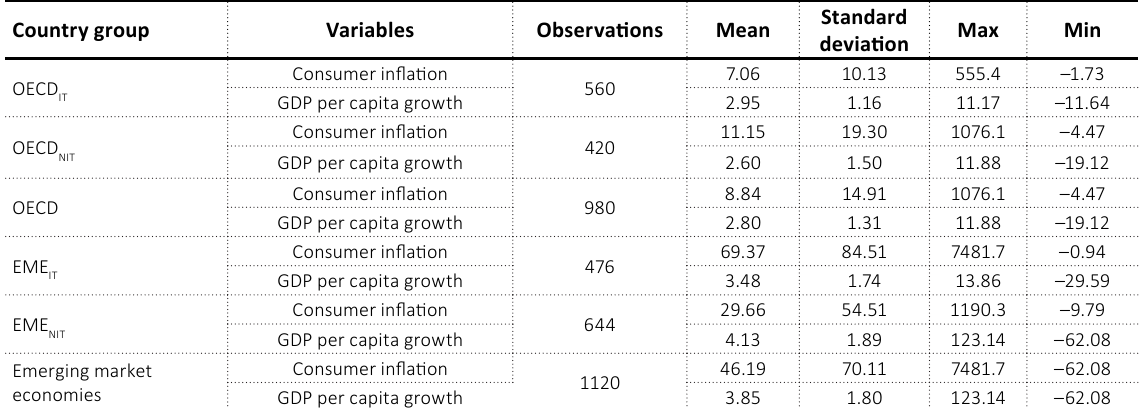
Table 1. Summary